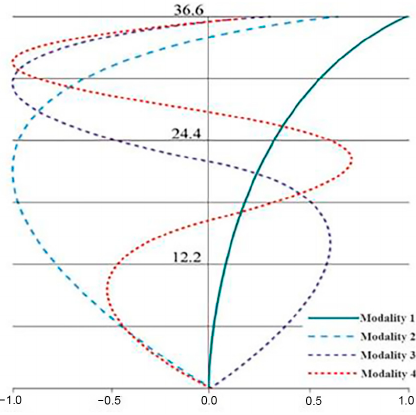
Figure 10. Modal deflection normalization.